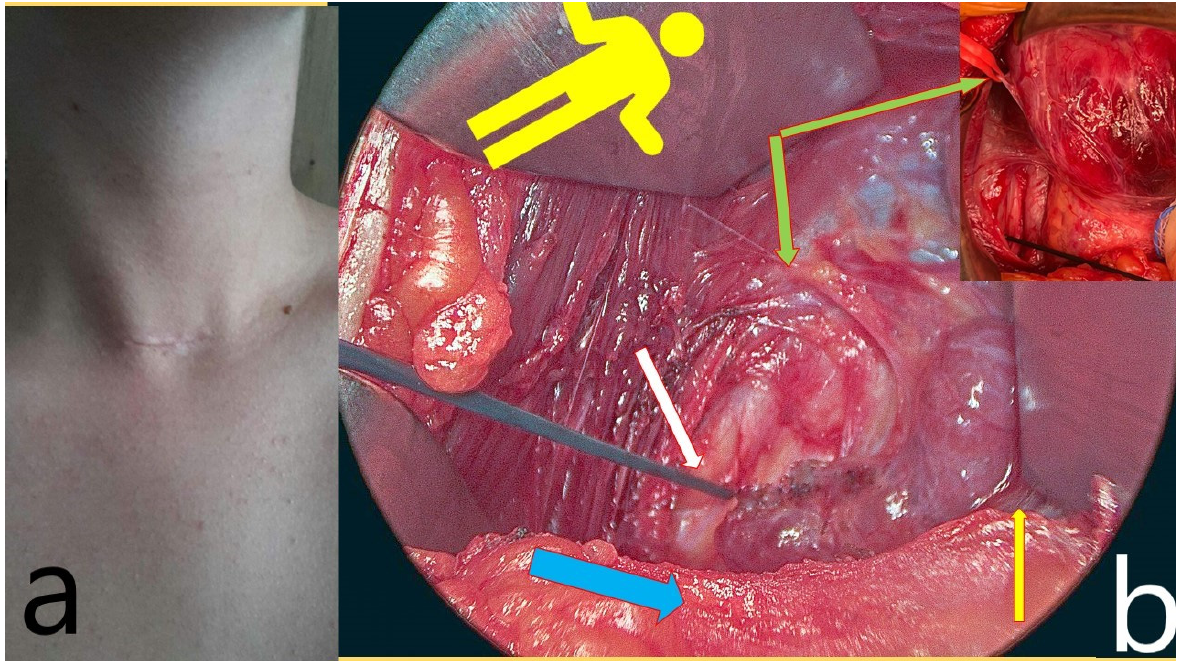
Figure 2. ( a ) A small 3-centimeter incision is used for minimally invasive open thyroidectomy. ( b ) The yellow figure indicates the patient’s orientation on the Operation table. The white arrow shows the vagal nerve stimulation point ADNM-VN1, the yellow one shows the strap muscle, separated from the sternocleidomastoid but intact over the anterior thyroid capsule, which is retracted medially, and the green arrow shows the middle thyroid vein entering the internal jugular vein (upper right corner, in the red vessel loop. Finally, the blue arrow shows the manubrium of the sternum.